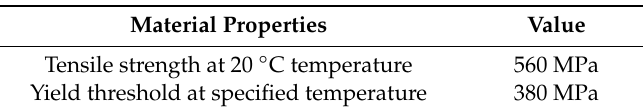
Table 2. Mantle material